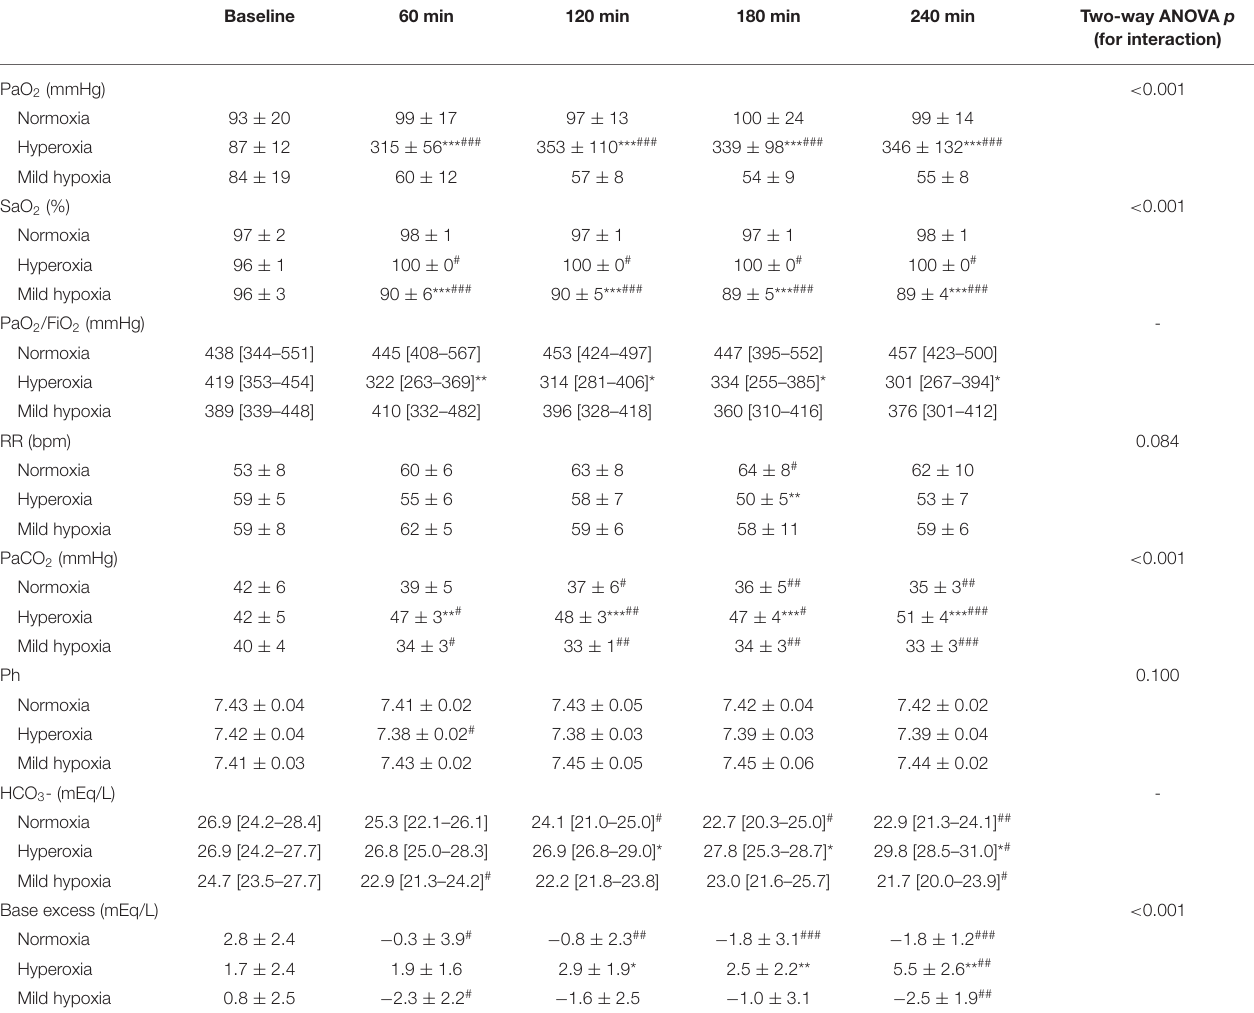
TABLE 1 | Blood gas